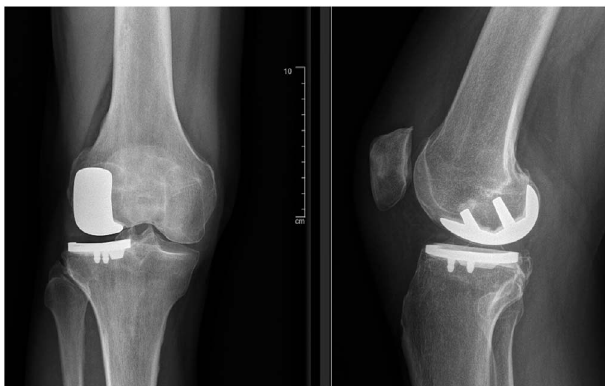
Figure 3. Medial Journey ™ UKA, (AP view and pro fi